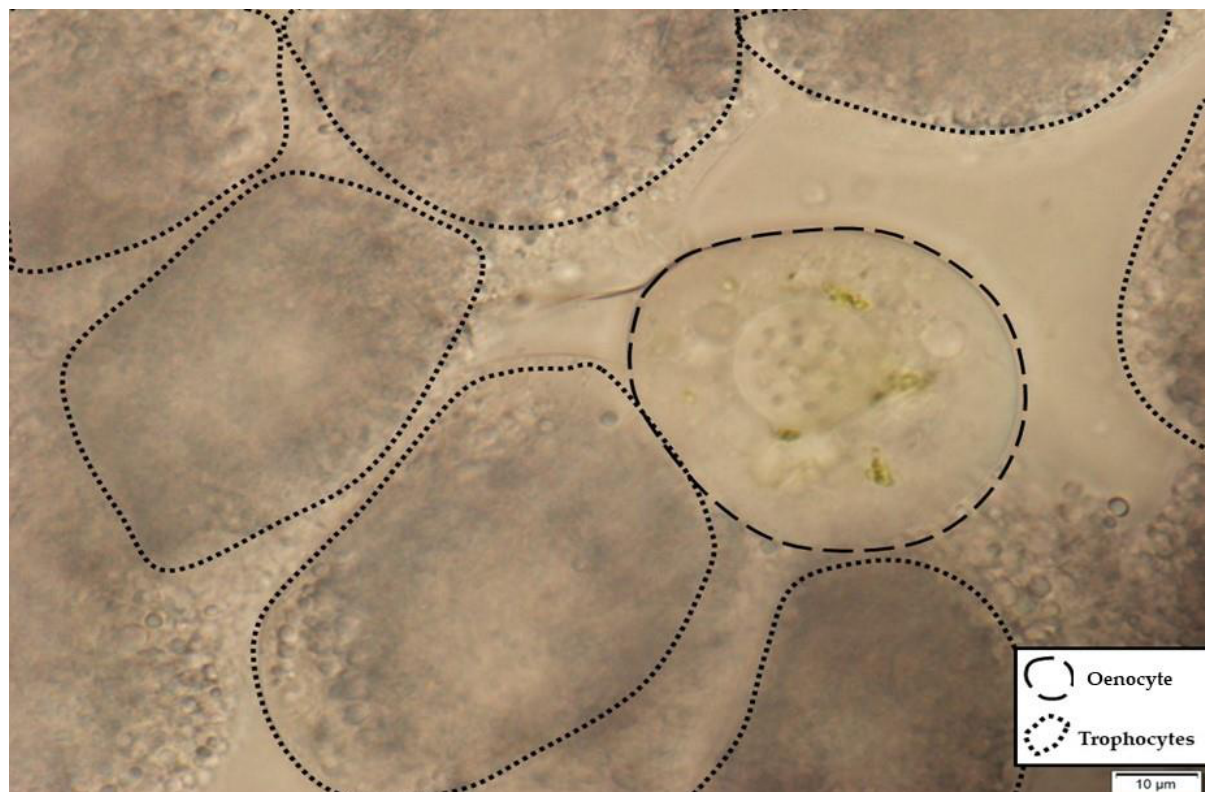
Figure 1. Subcuticular fat body cells under a light microscope: trophocytes and oenocyte.